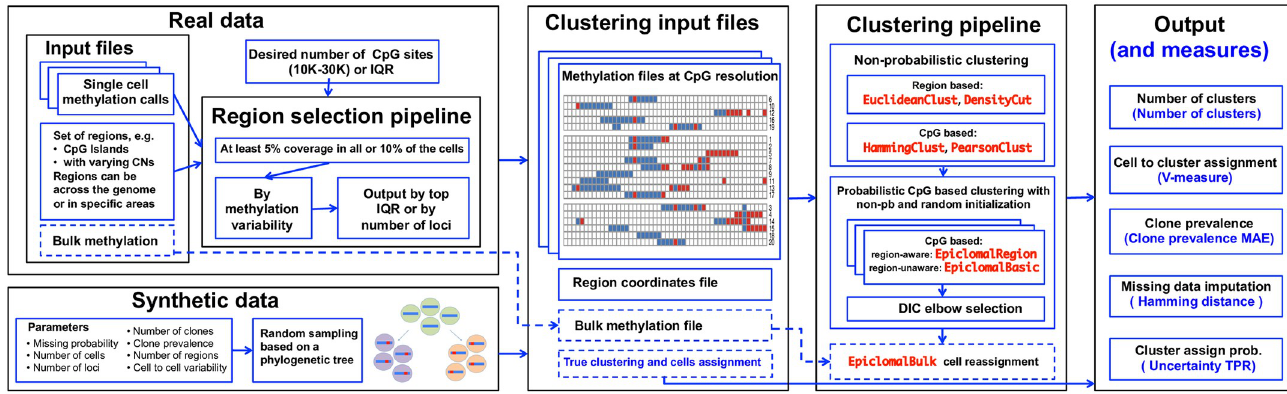
Fig 2. The three components of our proposed framework. Input data and pre-processing : data from regions of interest are extracted from methylation call files, which can be filtered to keep only data from regions with a desired amount of missing data and methylation level IQR. A synthetic data pipeline is also provided to simulate data under different parameters. Clustering : cells are clustered using different non-probabilistic clustering methods, with results that will then be used as initial values for Epiclomal methods. Output and performance measures : different metrics are provided to evaluate the output of each method when true cluster assignments are